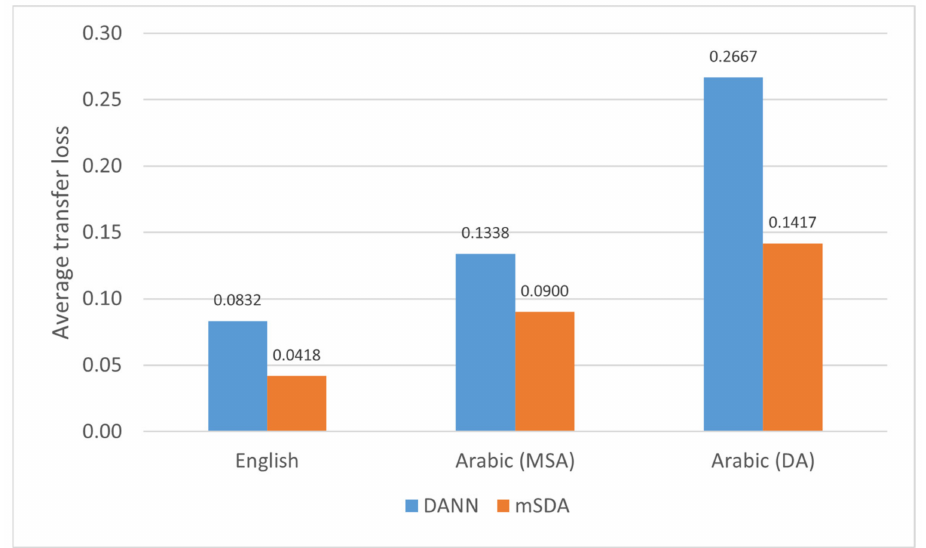
Figure 4. Average transfer loss of DANN and mSDA on Arabic and English